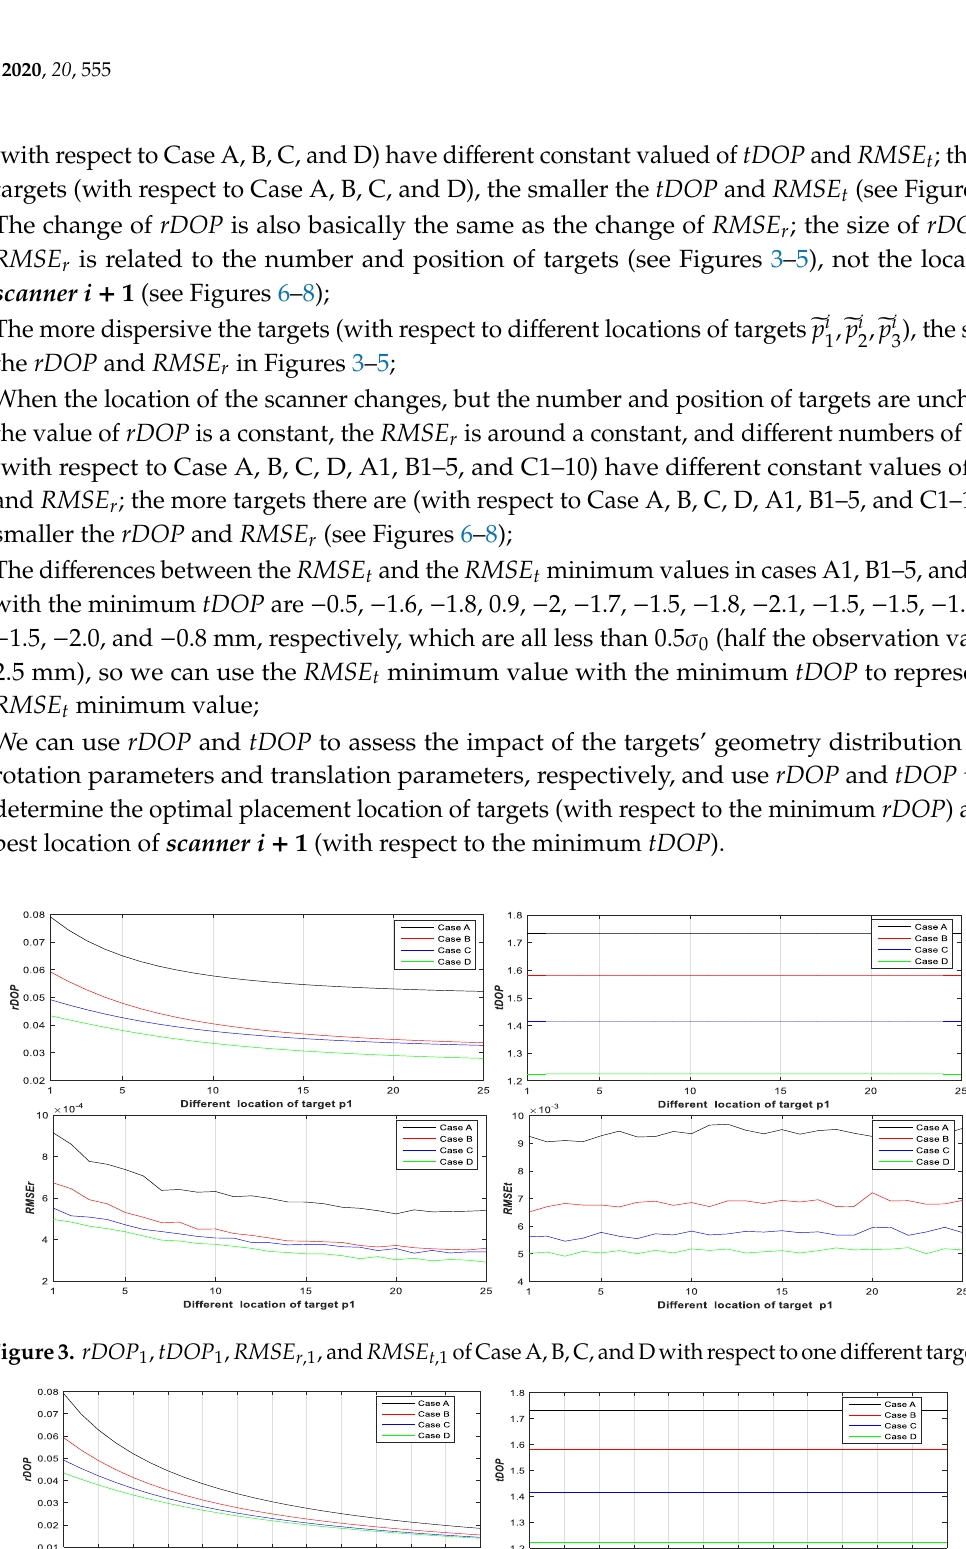
Figure 1. The target geometry of experiment I.